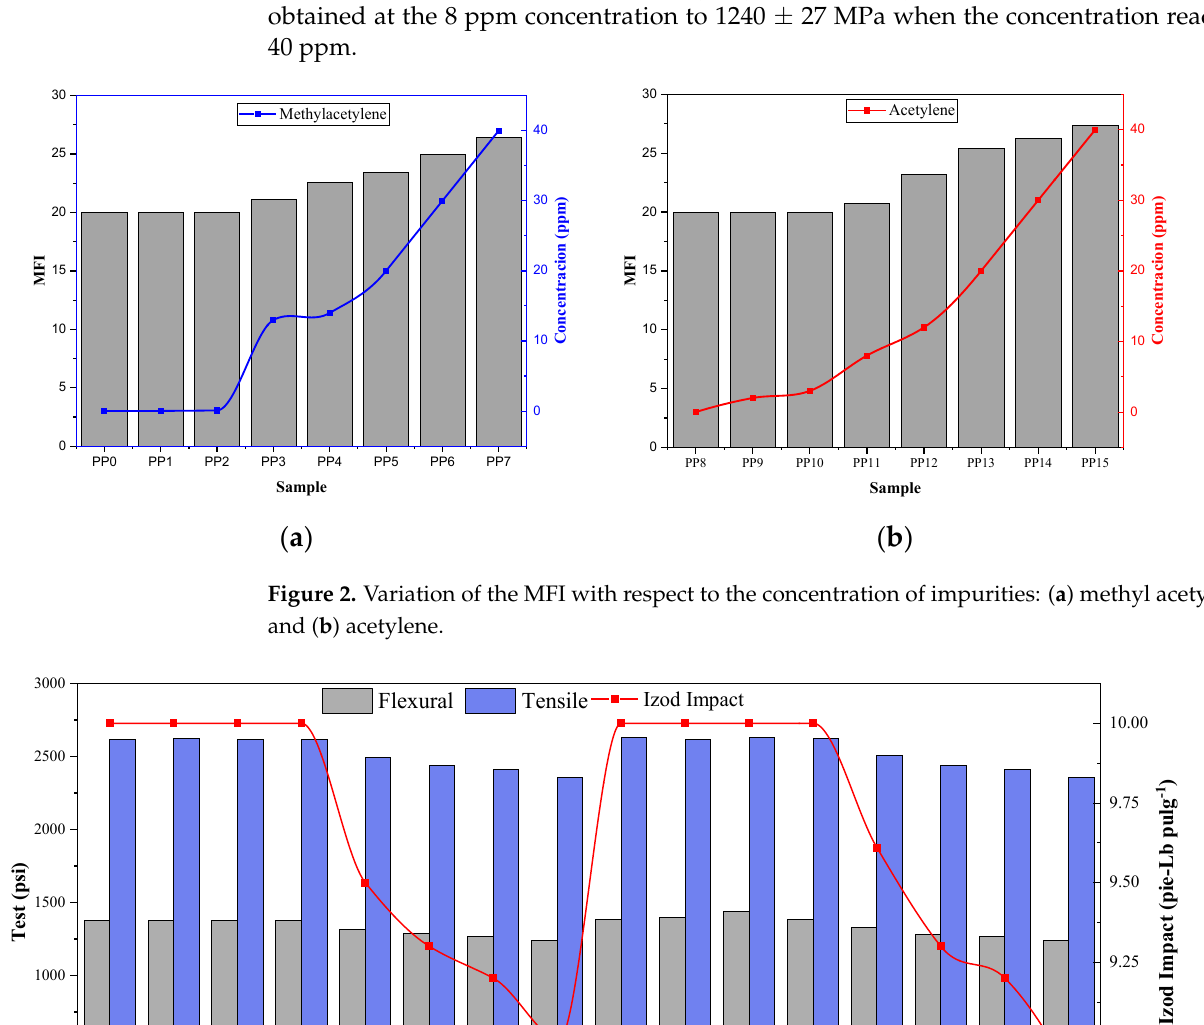
Figure 2. Variation of the MFI with respect to the concentration of impurities: ( a ) methyl acetylene and ( b ) acetylene.